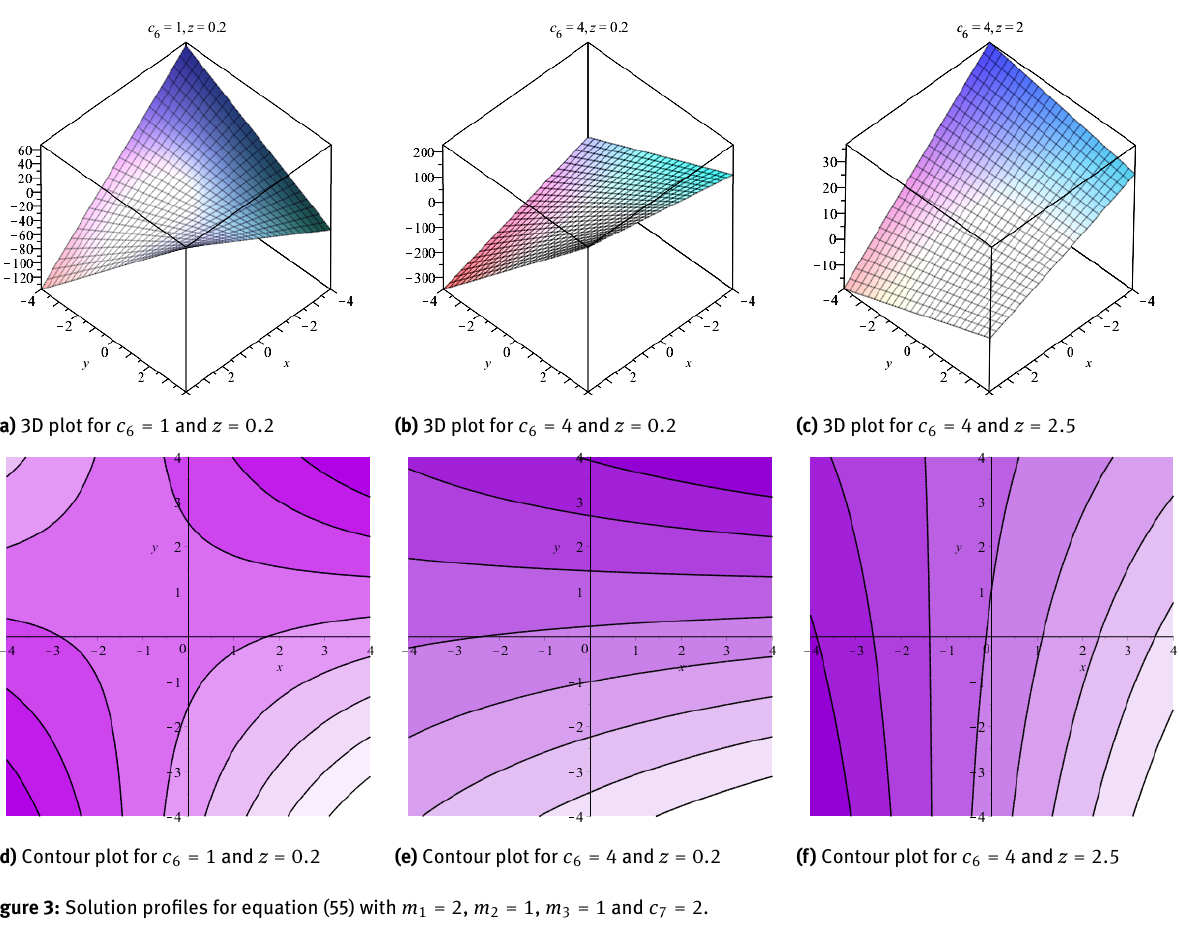
Figure 3: Solution profiles for equation (55) with m 1 = 2 , m 2 = 1 , m 3 = 1 and c 7 = 2